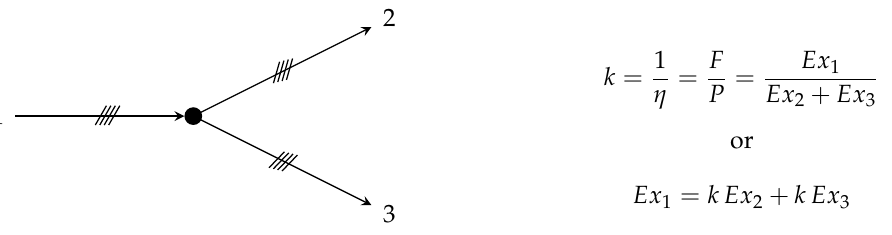
Figure 3. Generic electric power distribution system as an example of application of Rule